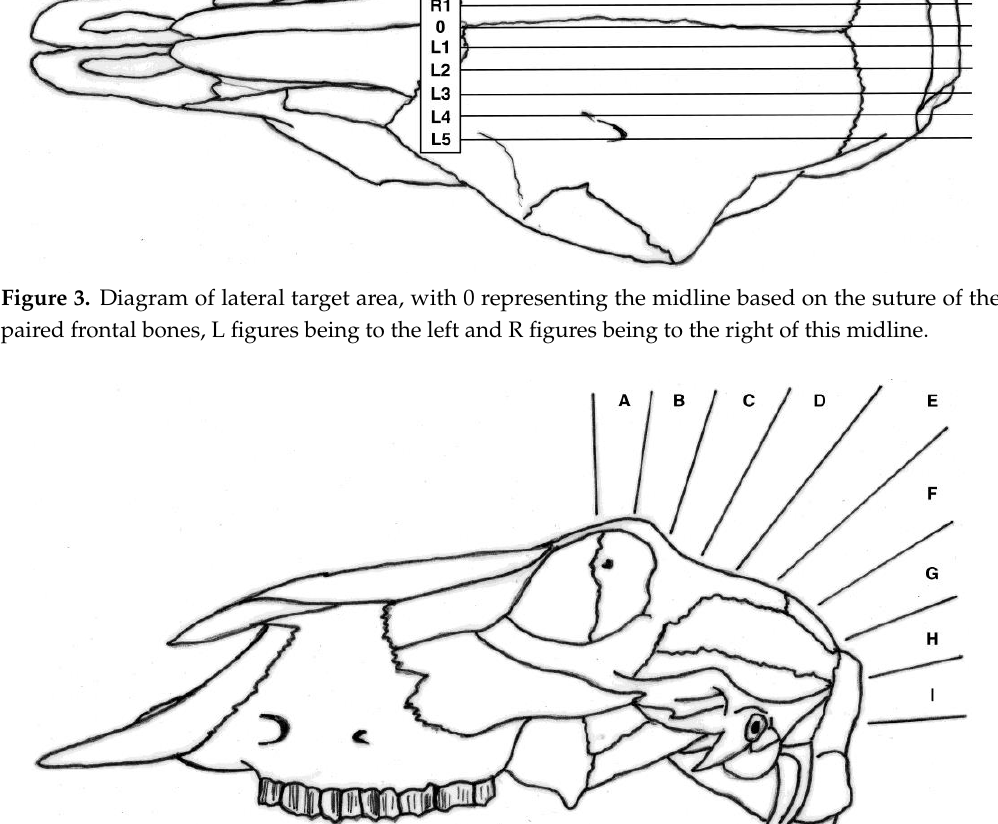
Figure 4. Diagram of sagittal targeting areas using surface topography with F representing a shot on the frontal–parietal suture, G on the parietal bone, H on the parietal–occipital suture etc. Each head was removed from the bag once the number had been noted; the ear tag number was checked to ensure correlation. The head was split on the sagittal plane using an electric band saw (Startrite Meat Master, UK) and both sides were photographed on the medial plane with a digital camera and post mortem findings recorded.